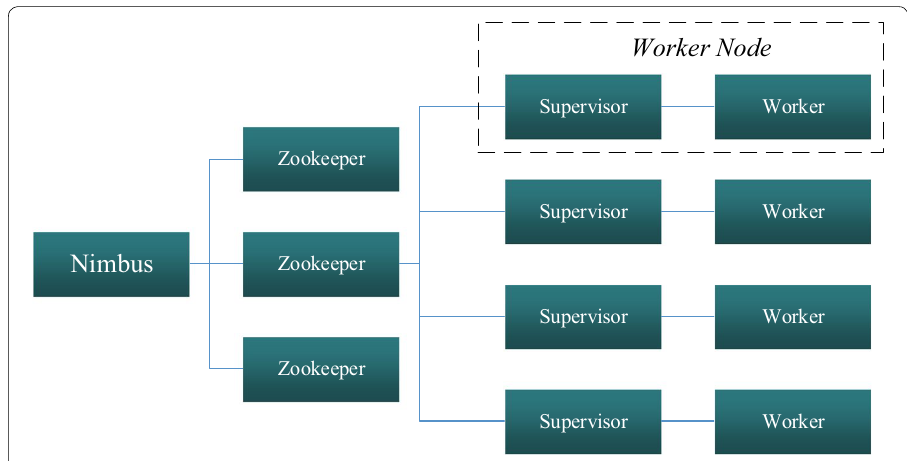
Fig. 4 High level architecture of Apache